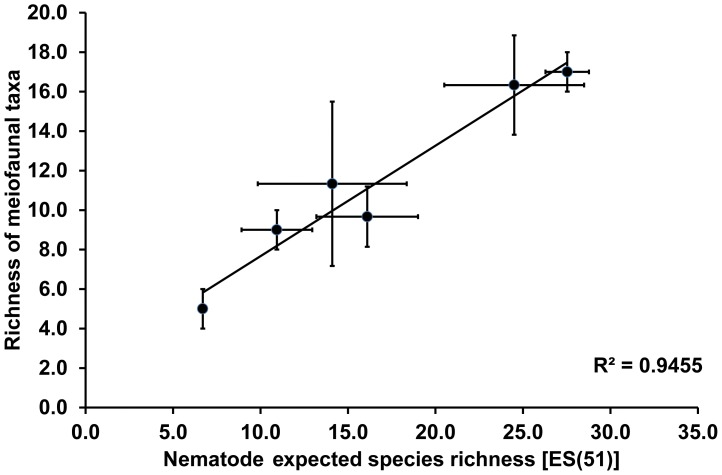
Relationship between richness of meiofaunal taxa and nematode biodiversity as ES(51) in tropical habitats from different oceanic regions.Illustrated are mean values ± standard deviation.